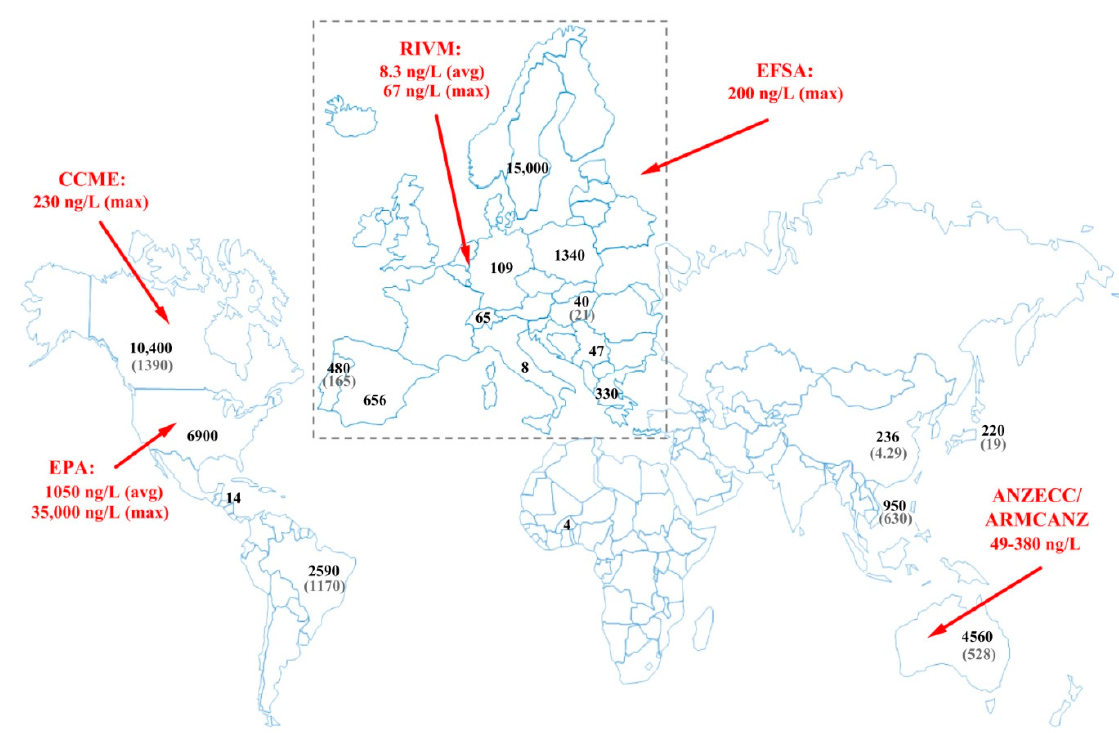
Figure 5. The maximum and the corresponding average concentrations in surface waters reported worldwide. Data are referred in this publication or in ref. [22,39,40]. The indicated quality reference values: European Food Safety Authority (EFSA) no observable effect concentration (NOEC) [41], Rijksinstituut voor Volksgezondheid en Milieu (RIVM) Nederland maximum permissible concentration and long term exposure [42,43], US-EPA aquatic life benchmark [44], Canadian Council of Ministers of the Environment (CCME), water quality guideline [45], Australia and New Zealand proposed aquatic ecosystem protection guideline values depending on species protection goals (80%–99%) [46] and a default guideline value proposed by third parties is under peer review process [47].